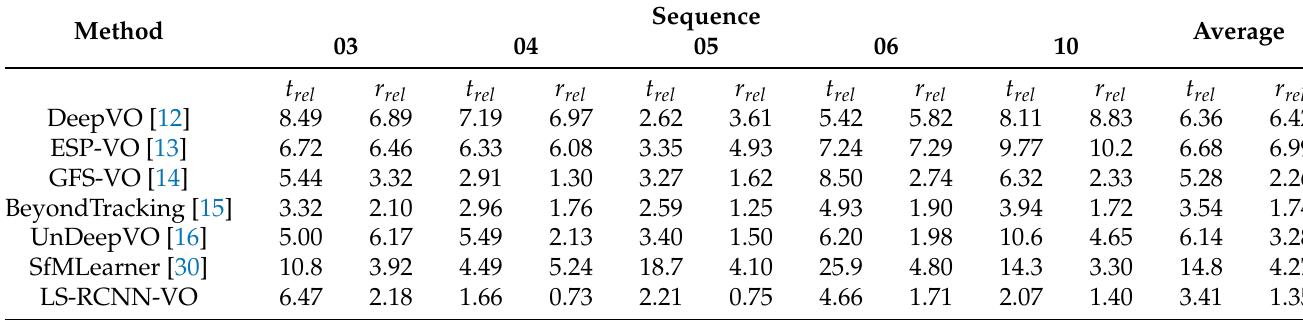
Table 5. Comparison with other works according to Root Mean Square Errors (RMSE) of the relative translational and rotational errors on the KITTI